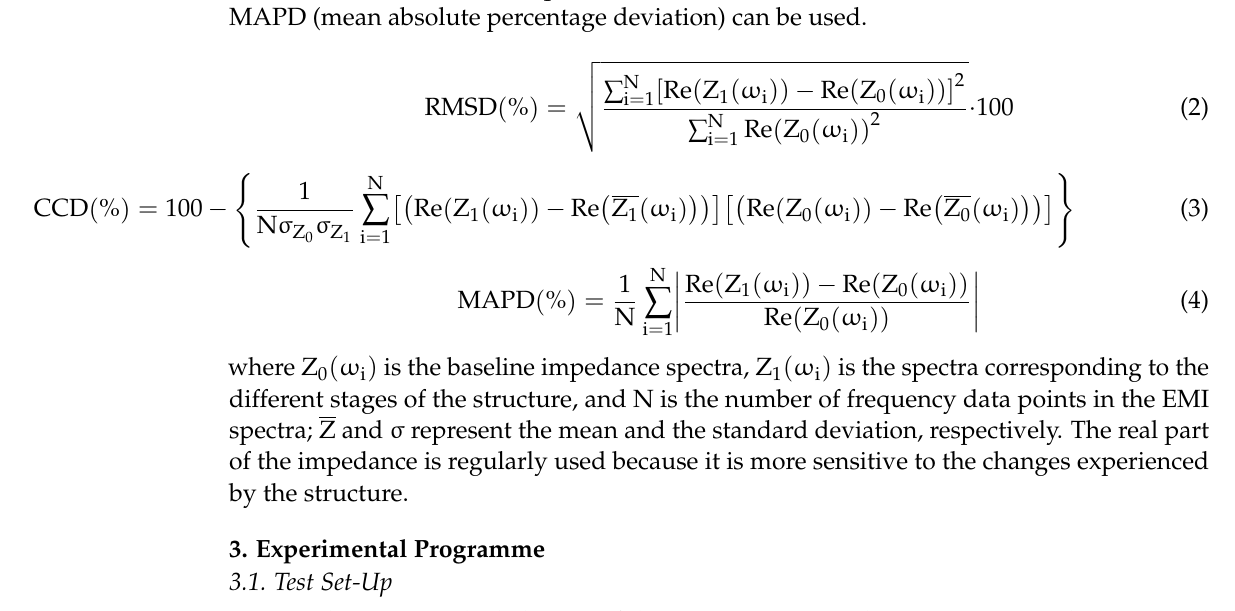
Figure 2. Experimental set-up. For the EMI tests, eight PZT patches (PZT1 to PZT2 and PZT5 to PZT9 according to Figure 1) were bonded in different locations of the specimen to be analyzed. Inner sensors were directly bonded to the FRP laminate. PZT1 and PZT2 are sensors of type P-876.A12 (61 mm × 35 mm× 0.5 mm), while sensors PZT3 to PZT9 are sensors of type P-876.SP1 (16 mm × 13 mm × 0.5 mm). All of them are provided by Piceramic [25]. During the EMI tests, the impedance analyzer excites each bonded PZT patch using a voltage of 1 V with a frequency range between 10 kHz and 100 kHz and a frequency step of 12.5 Hz. The response of each PZT’s impedance is recorded with the same Agilent 4294A Impedance Analyzer, which is connected to a computer with a data acquisition software implemented in VEE. Five frequency sweeps were conducted for each sensor at each test, resulting in five impedance signals that were averaged in order to obtain the impedance signal that would be later on used for the analyses. 3.2. Loading Procedure The loading history applied to the specimen typically consisted of several sustained four-point loading tests and their subsequent unloading. Five different levels of increasing sustained loading were applied along the history, 8, 9.3, 13.7, 17.7, and 19.6 kN. The first three levels correspond to the cracking load plus 15%, 35%, and 100%, respectively. The fourth level is associated with the steel reinforcement yielding and, finally, in the fifth level, being the steel reinforcement in the yielding state, the increment of internal tensile force was practically supported by the FRP reinforcement. For each level, the test was